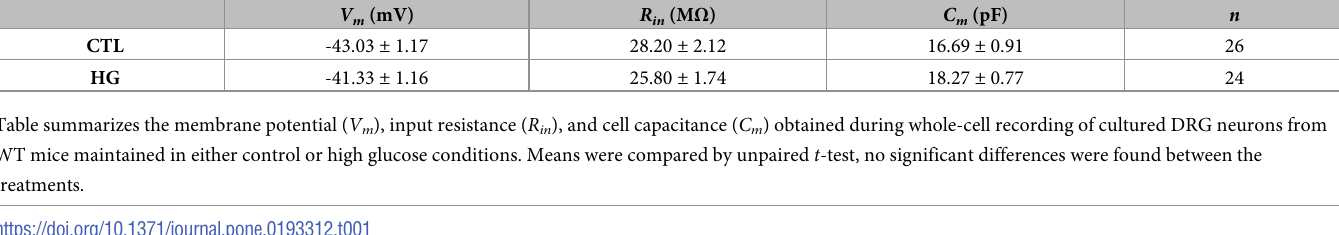
Table 1. Passive membrane properties for cultured DRG neurons from wild type mice.